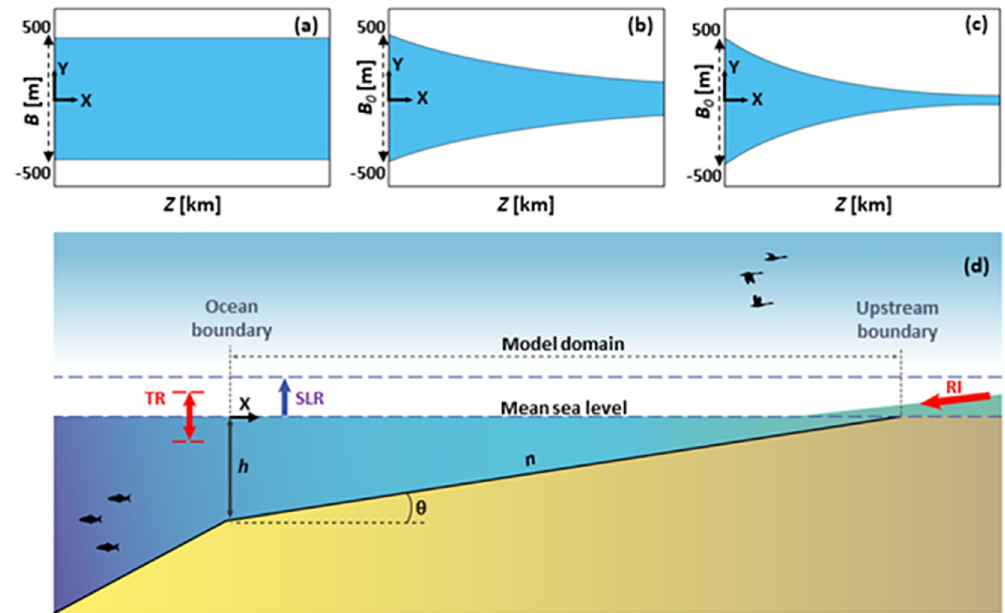
Fig 1. Estuarine geometries considered in this study; top view of (a) prismatic; (b) converging with L c = 160 km; and (c) converging with L = 80 km estuaries. Panel (d) shows a side view of these geometries with the applied boundary conditions. c